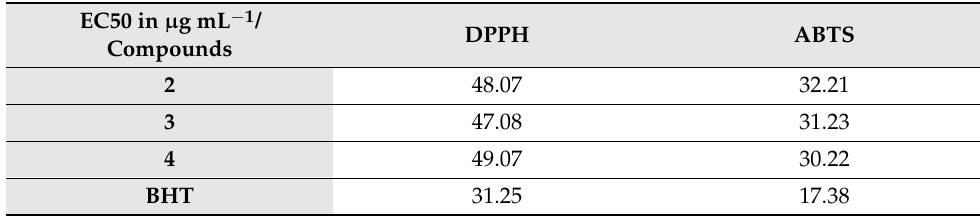
Table 10. Antioxidant activity of the synthesized compound was assessed by DPPH and ABTS techniques and expressed as EC50 in µ g mL − 1 . The BHT was used as a